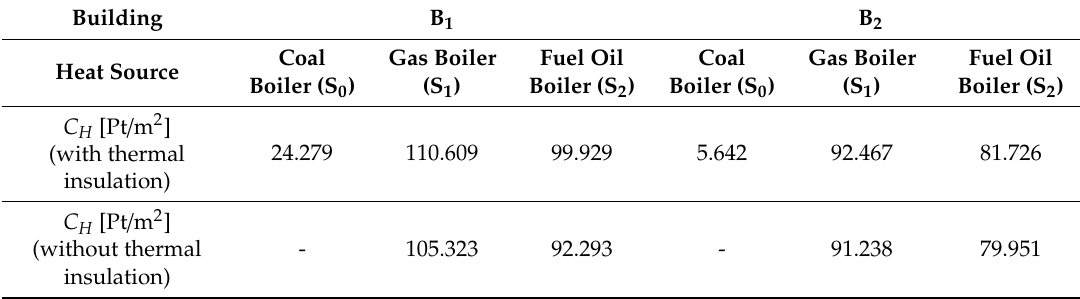
Table 6. Reduction of ecological heating